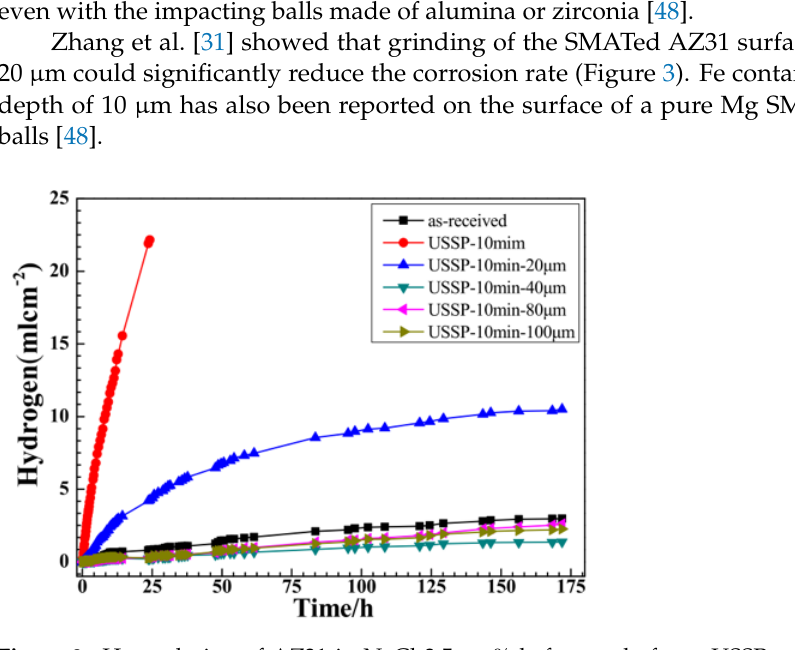
Figure 3. H 2 evolution of AZ31 in NaCl 3.5 wt.% before and after a USSP process. The length mentioned after each case indicates the thickness removed by grinding using 2000 grit size SiC paper. Reprinted from [31] with permission from Elsevier.